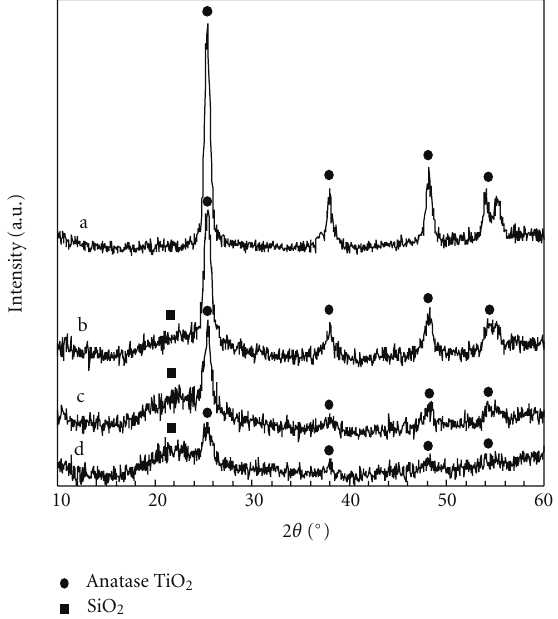
Figure 2: XRD patterns of TiO 2 and ST serial composite materials heated at 700 ◦ C for 5 minutes: (a) TiO 2 , (b) ST 1.5, (c) ST 3, and (D) ST 5.